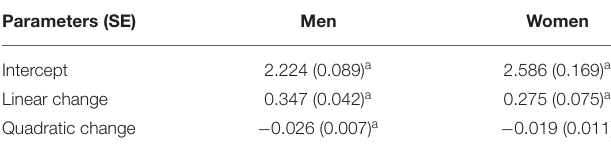
TABLE 4 | Burden of Adversity trajectories curve